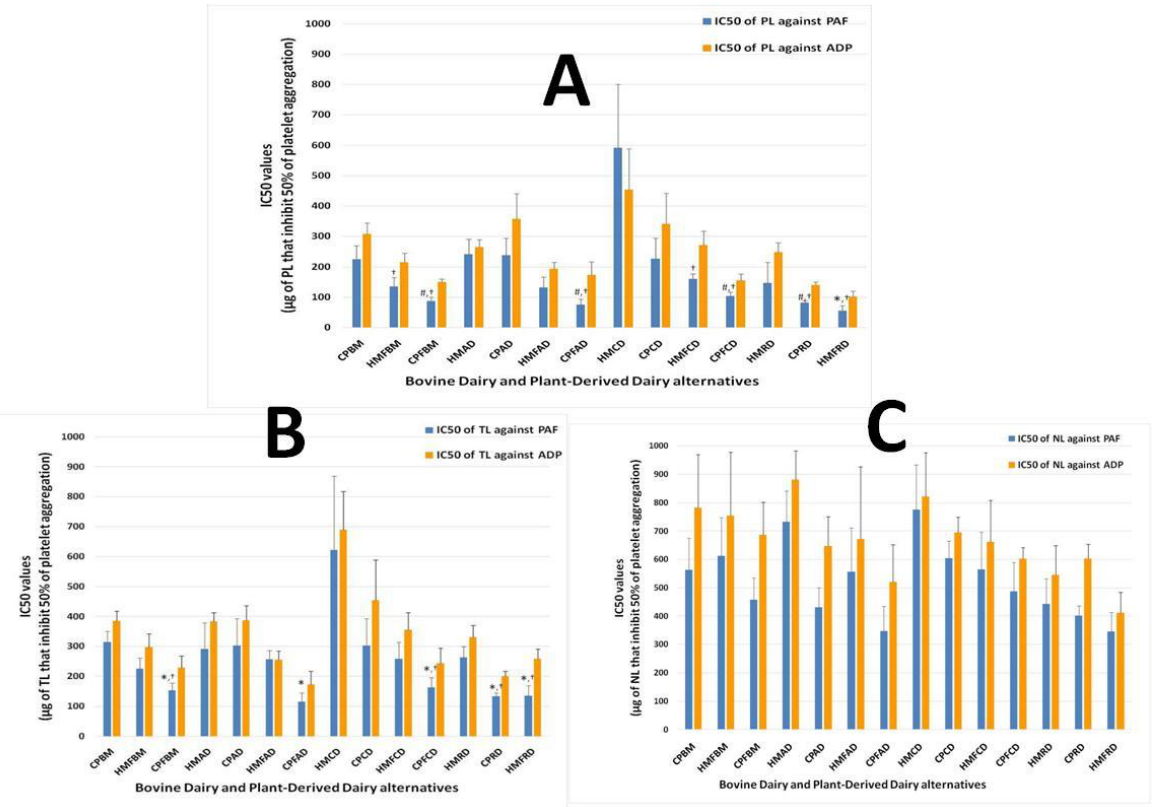
Figure 1. The anti-inflammatory and anti-platelet potency of bioactive PL ( A ), TL ( B ), and NL ( C ) from fermented and non-fermented plant-derived dairy alternatives, versus bovine milk and yogurt. The anti-inflammatory and anti-platelet potency of lipid bioactives from all samples were assessed against human platelet aggregation induced by the inflammatory and thrombotic mediator PAF (anti-PAF effects in blue bars) or by a classic platelet agonist, ADP (anti-ADP effects in yellow bars). Results are expressed as means of the IC50 values (half-maximal inhibitory concentrations) in µ g of lipid extract in the aggregometer cuvette that causes 50% inhibition of PAF/ADP-induced platelet aggregation (the lower the IC50 value for a lipid extract the higher its inhibitory effect against the specific agonist of platelet aggregation). * Denotes statistically significant difference ( p < 0.05) when the strongest anti-PAF potency (IC50 value) of the most bioactive lipid extracts were compared with those of all the other samples. # Denotes statistically significant difference ( p < 0.05) when the intermediate anti-PAF effects of the PL bioactives from the samples assessed were compared with those showing the lowest anti-PAF effects. † Denotes statistically significant difference ( p < 0.05) when the anti-PAF potency (IC50 values against PAF) of the lipid bioactives from a sample was compared to its anti-ADP potency (IC50 values against ADP) of the same sample. Abbreviations: PL: polar lipids; TL: total lipids; NL: neutral lipids; PAF: platelet-activating factor; ADP: adenosine 5 (cid:48) diphosphate;